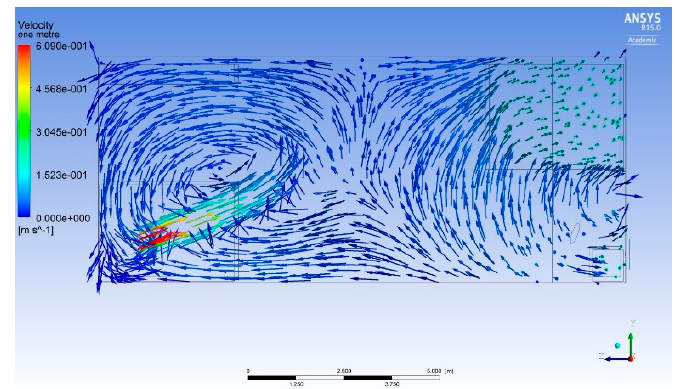
Figure 8. Side view of Anoxic zone 3 adjacent to common wall of zone 2 and 3.